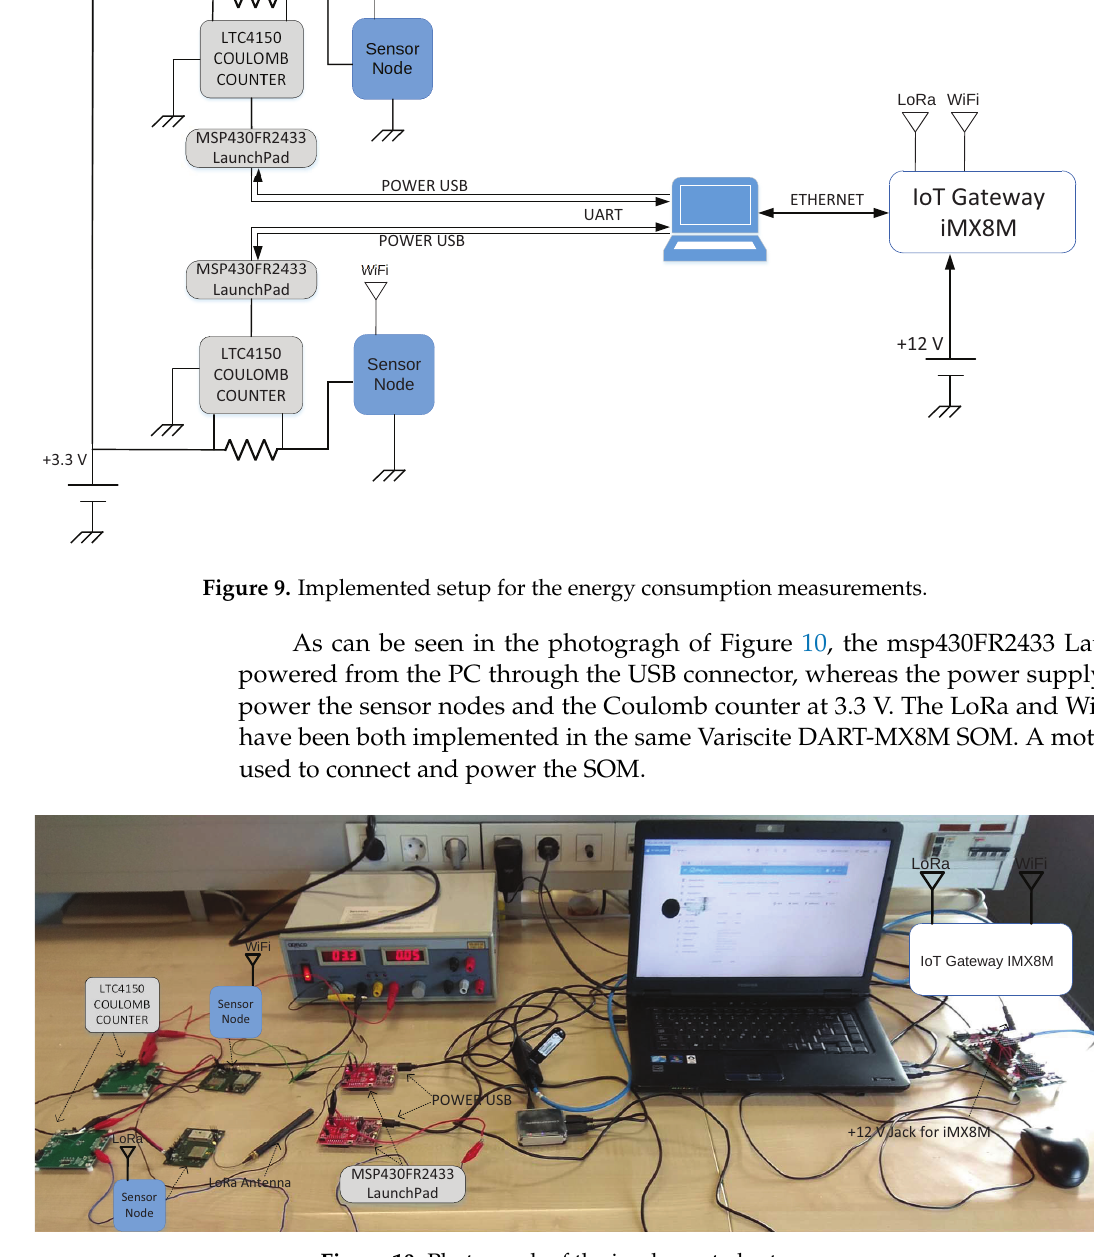
Figure 10. Photogragh of the implemented